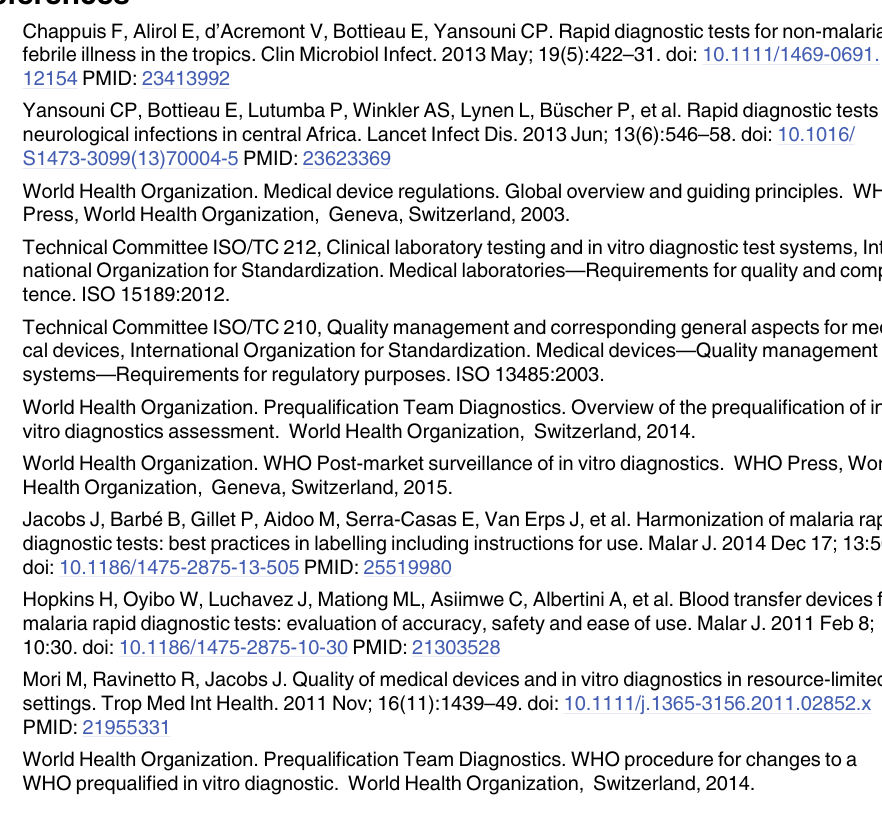
S1 Table. Checklistfor rapid diagnostic tests used as index tests in NIDIAG persistent fever